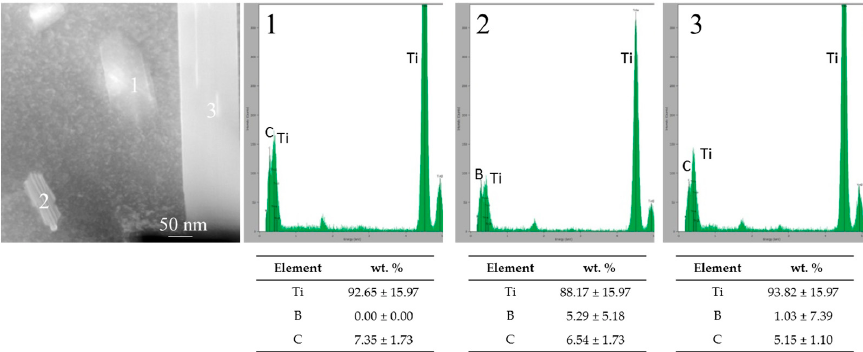
Figure 7. Nano-scale TEM images of precipitates: ( a ) striped polygonal shape; ( b ) striped and non-striped polygonal shape; ( c ) striped and non-striped whisker.